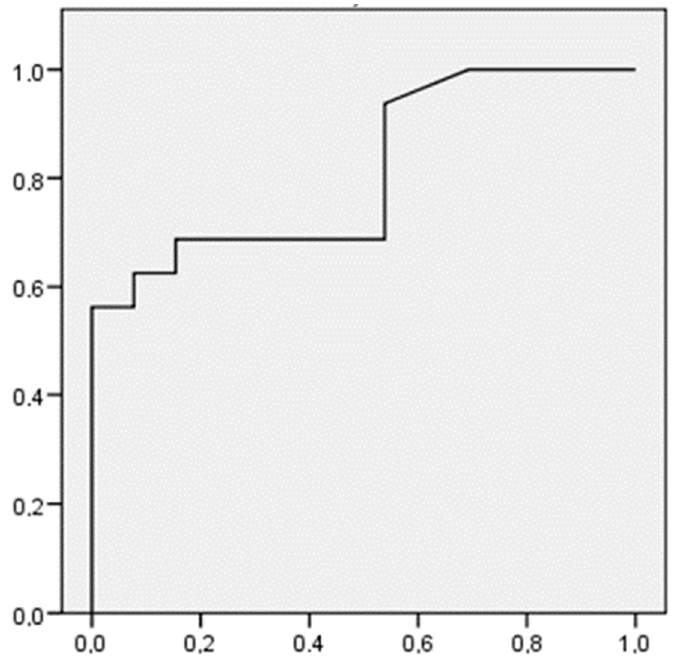
Figure 1. ROC curve for Crohn’s patients belonging to the group with low external locus of control.